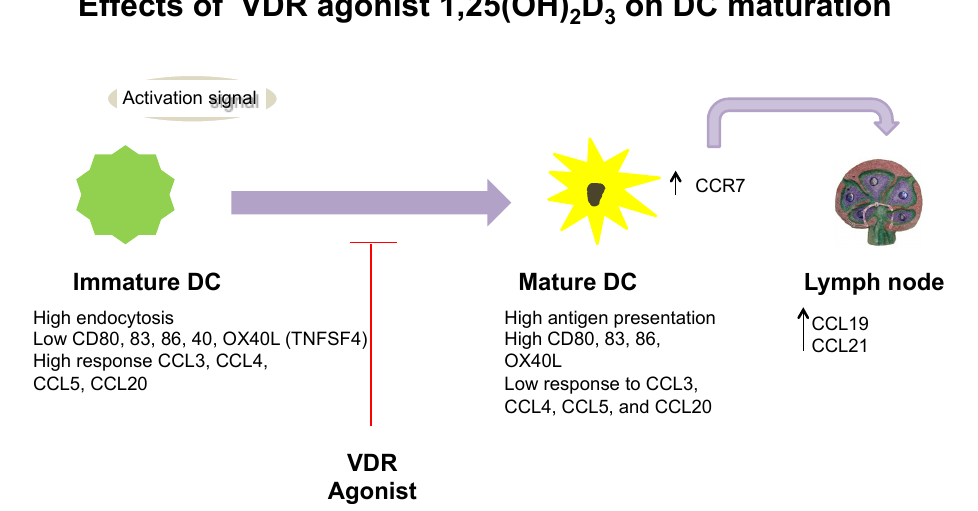
Figure 1. Overview of vitamin D on dendritic cell (DC) function.